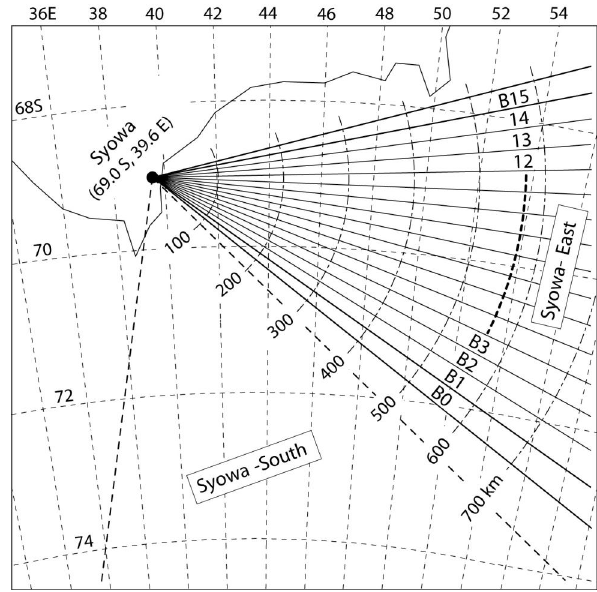
Figure 1. Field of view for the Syowa-East HF radar with a 16-beam coverage (beams 613 Fig. 1. Field of view for the Syowa-East HF radar with a 16-beam coverage (beams numbered as B0, B1, B2, ..., B15). Ground ranges from Syowa Station and the Syowa-South HF radar field of view are numbered as B0, B1, B2, …, B15). Ground ranges from Syowa Station and the 614 also indicated with curved dot-dashed lines and black dashed lines, Syowa-South HF radar field of view are also indicated with curved dot-dashed lines and 615 black dashed lines, respectively. 616